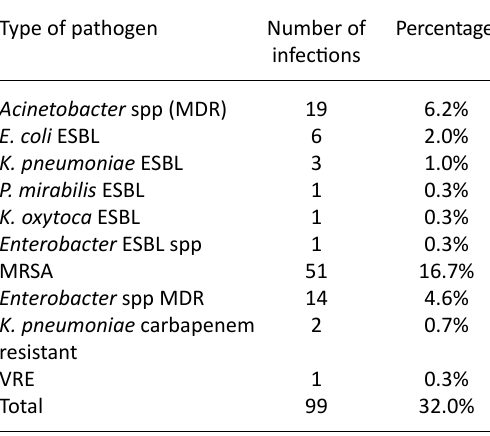
Table 4-A.2. High drug-resistant isolates of wound